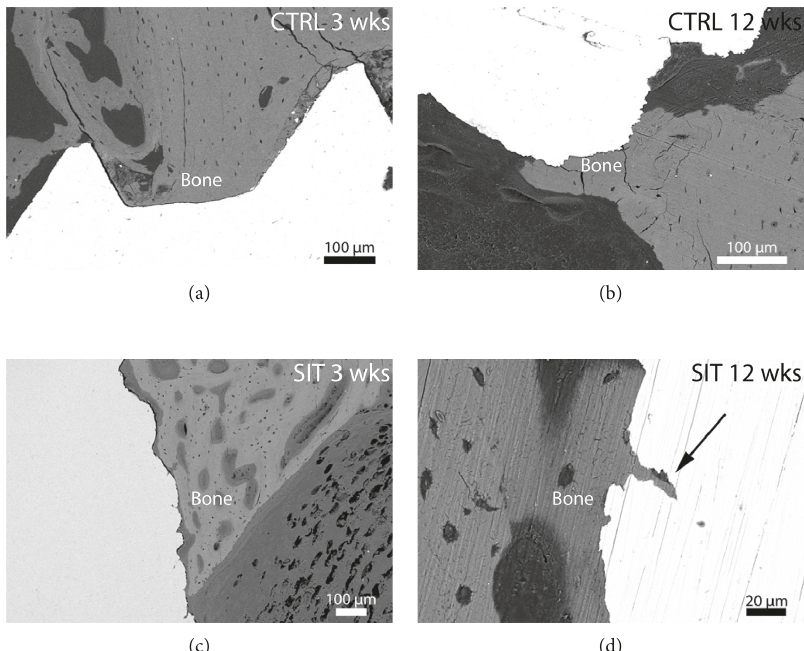
Figure 8: BSE-SEM images of the bone-implant interface after 3-week (a, c) and 12-week (b, d) implantation for (a, b) control and (c, d) SIT devices. Bone conduction along and into the microporosities of the SIT implant was observed after 12 weeks (arrowhead).